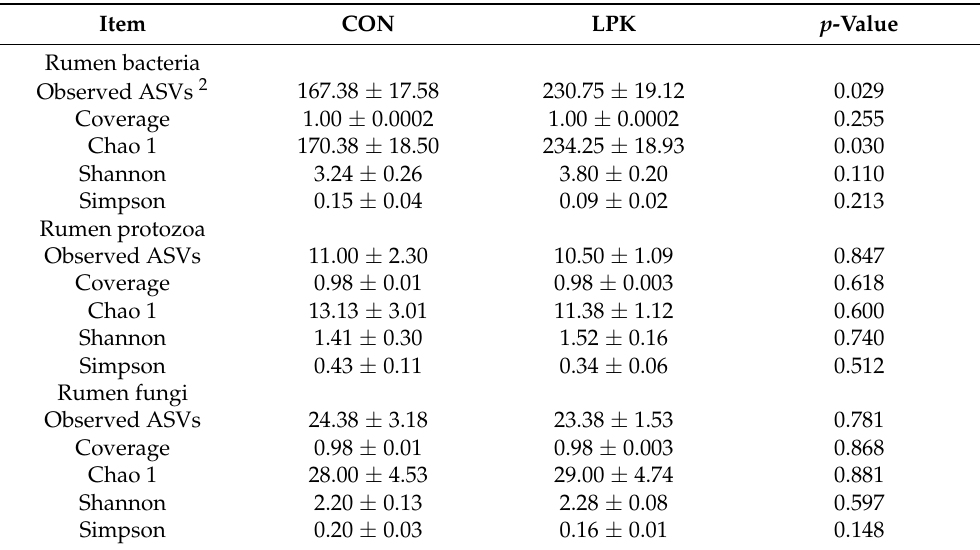
Table 5. Effects of live Pichia kudriavzevii on microbial community diversity in the ruminal content of Hu sheep 1 .